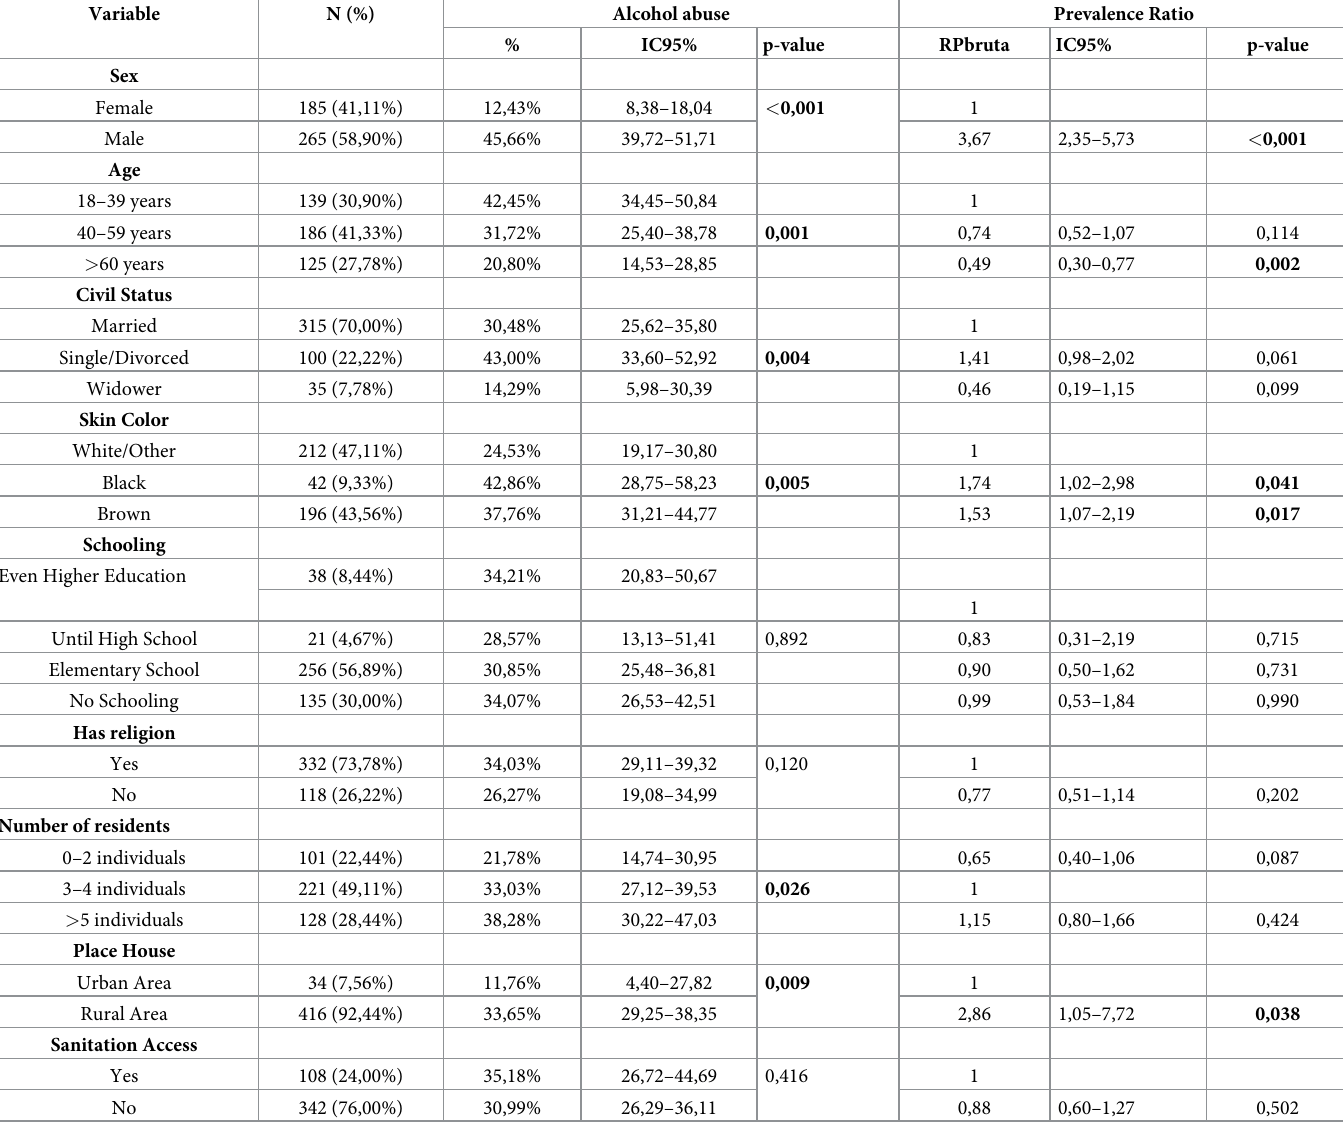
Table 1. Descriptive and bivariate analysis of alcohol abuse and its association with socio-demographic variables of farmers in the municipality of Caico´-RN.